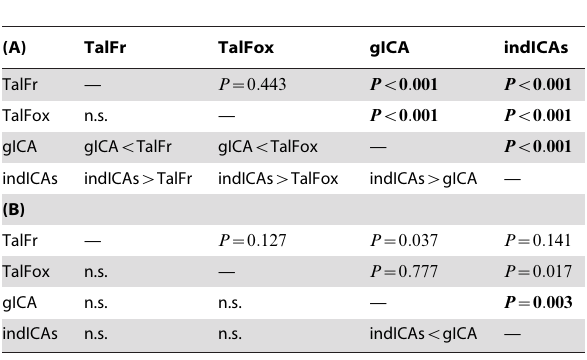
(A) Variance. (B) Absolute variance change. Upper triangular matrix: significance level of an effect of method. Significant P -values at a threshold of p ~ 0 : 05 corected are emphasized in bold. Lower triangular matrix: direction of effect; n.s.: nonsignificant. Note that, since changes are usually negative, a larger change means a change that is smaller in amplitude.